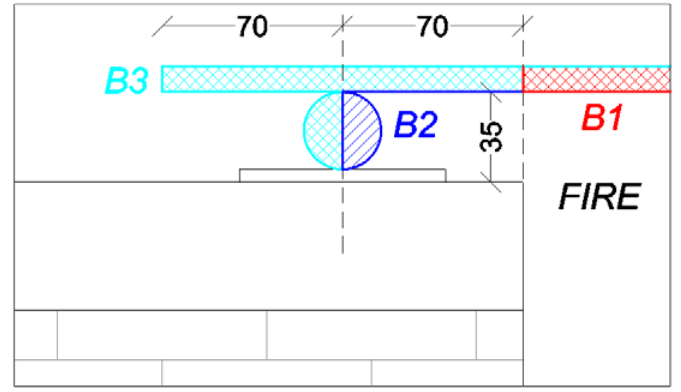
Fig. 8 Thermal exposure of MR models (schematic cross-section view in the region of supports). Nominal dimensions in